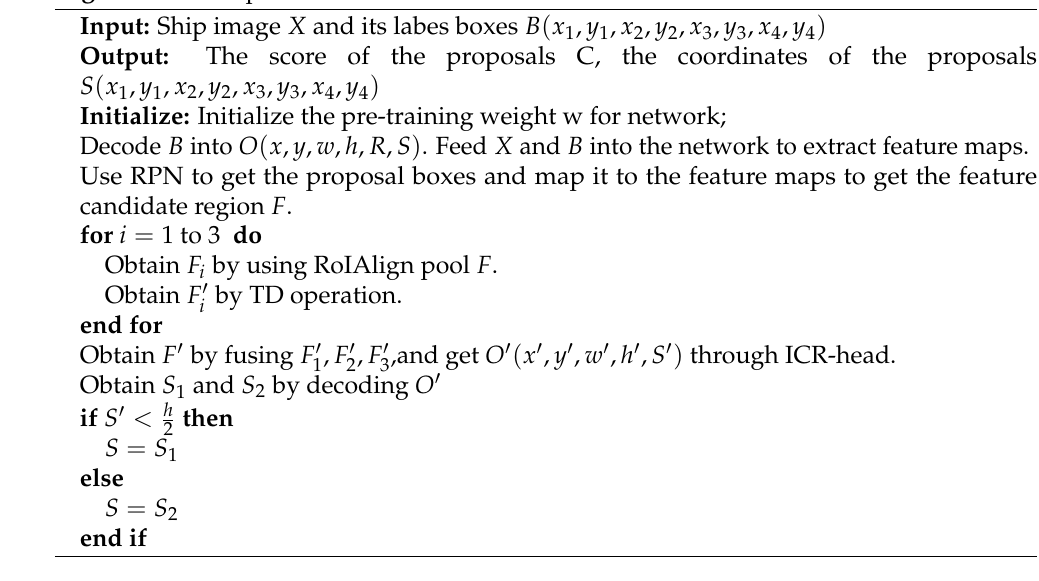
Algorithm 1 The pseudocode for